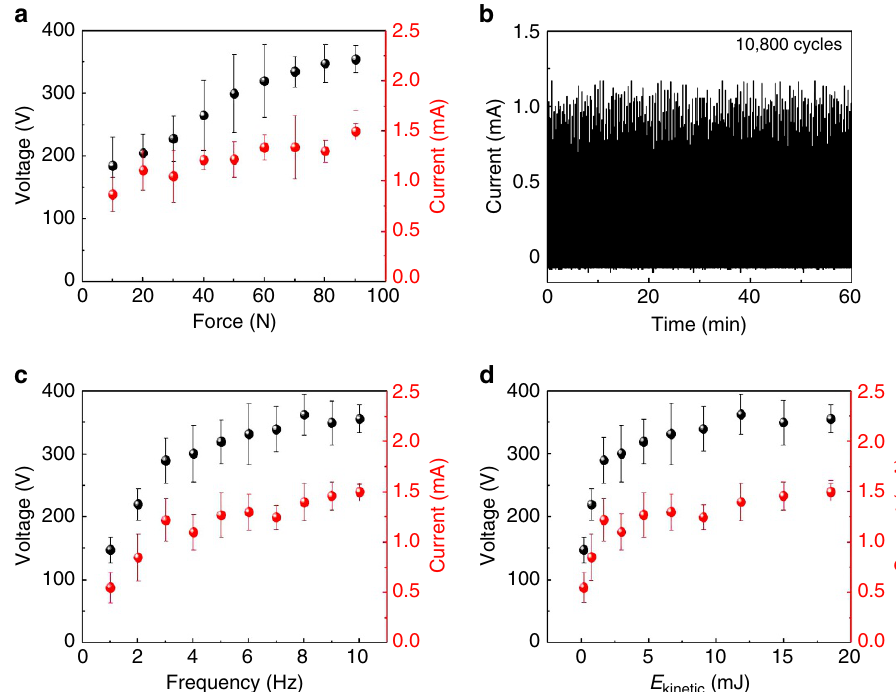
Figure 4 | Electrical outputs of three-layer structured triboelectric nanogenerator under various forces and frequencies. ( a ) The output current and voltage generated by three-layer structured TENGs under various forces from 10 to 90N, ( b ) stability and durability test of the TENG under cycled compressive force of 30N, ( c ) working frequencies from 1 to 10Hz and ( d ) kinetic energies from 0.18 to 18.48mJ. All error bars in the figure represent s.e.m. of the